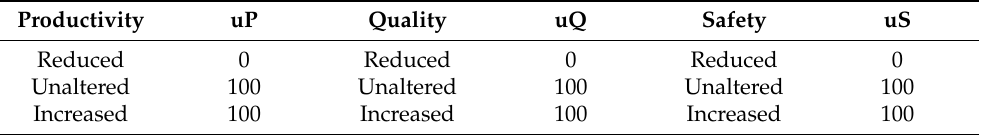
Table 5. Subjective utilities outcomes, where 0 is the worst outcome and 100 the best possible